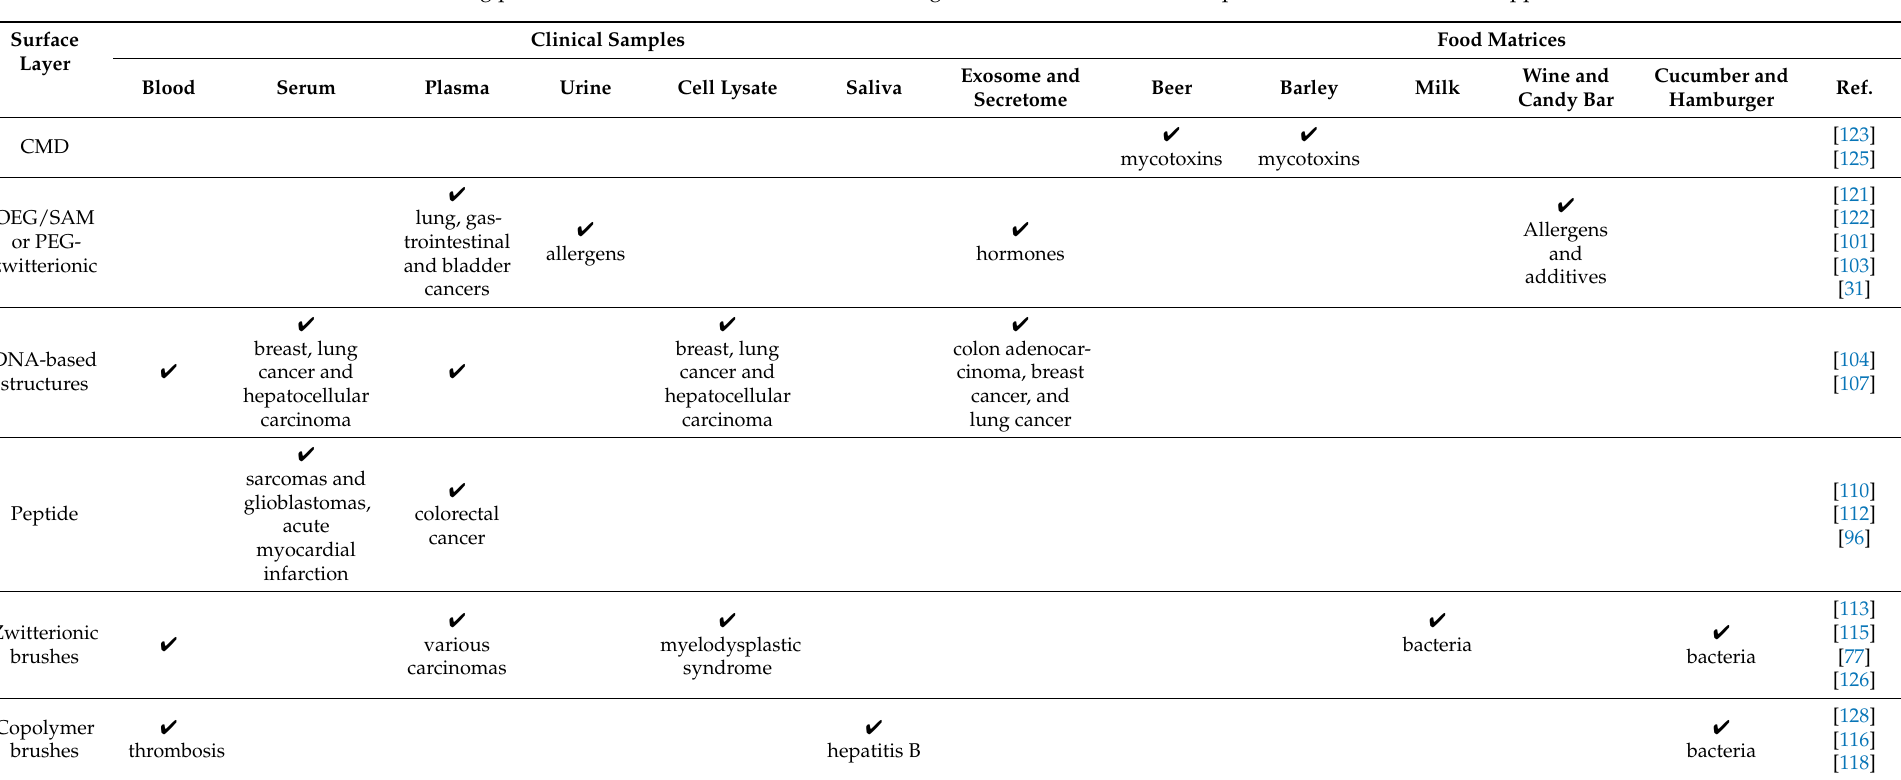
Table 2. Best antifouling performances of the different surface coatings described in this review, reported for clinical and food applications. Surface